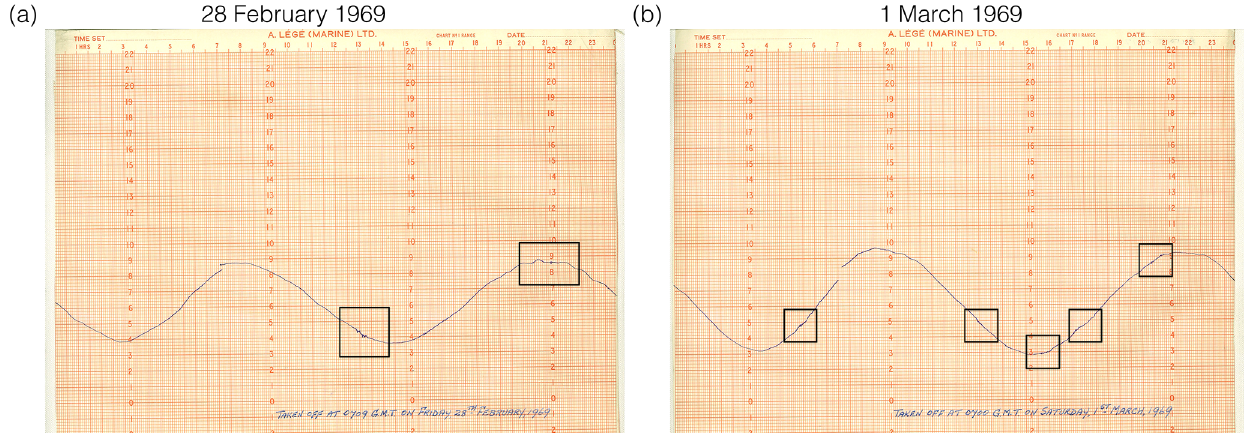
Figure 2. Tide gauge recordings at Belfast harbour on (a) 28 February 1969 and (b) 1 March 1969. Minor oscillations can be seen upon close inspection (black boxes), with the first wave arriving at approximately 13:00. Retrieved through personal contact with the Permanent Service for Mean Sea Level (2016) (Holgate et al., 2013).